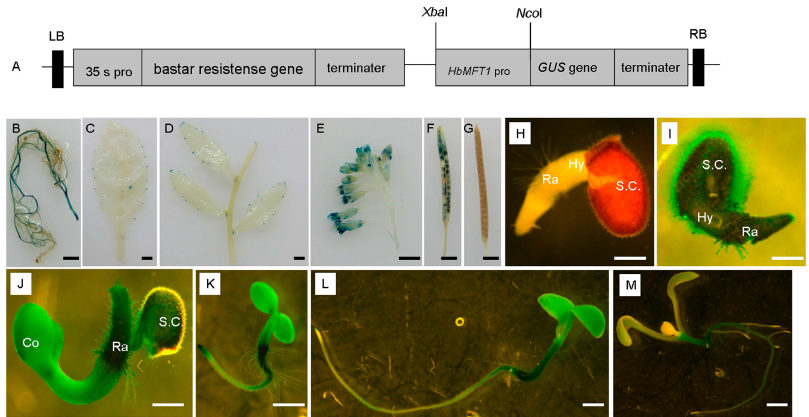
Figure 5. HbMFT1::GUS ( β -glucuronidase) activity analysis in transgenic Arabidopsis plants. ( A ) Schematic of T-DNA structure of pCAMBIA3301 recombinant construct. Various tissues of adult transgenic plant harboring HbMFT1::GUS fusion, including root ( B ); rosette leaf ( C ); stem with cauline leaves and axillary meristems ( D ); flowering inflorescence ( E ); mature silique ( F ); wild-type mature silique ( G ); wild-type seedling at 12 h after germination (HAG) ( H ); seedling at 12 HAG ( I ); seedling at 1 day after germination (DAG) ( J ); 3 DAG ( K ); 5 DAG ( L ); 7 DAG ( M ). bar = 2 mm for ( B – G ), bar = 0.2 mm for ( H – J ), bar = 1 mm for ( K – M ). Co: cotyledon, Ra: radicle, Hy: hypocotyl, S.C.: seed